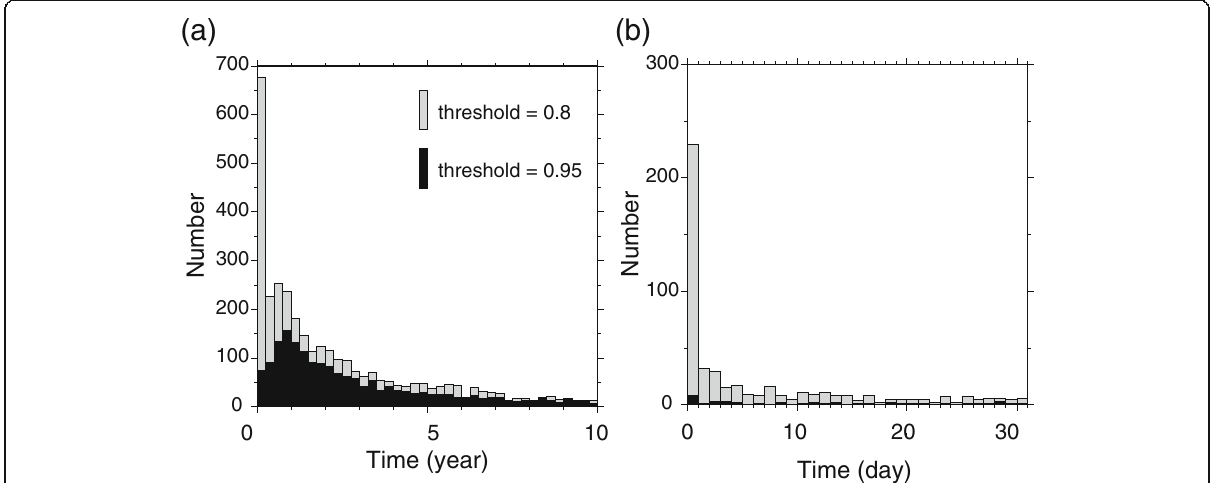
Fig. 8 Frequency distribution of the intervals of successive events using coherence thresholds of 0.8 (gray) and 0.95 (black). a 0 to 10-year range in 0.25 year bins. b 0 to 31 days in 1-day bins. The frequency range is 1 – 8 Hz and data used was from 1984 to 2006 offshore